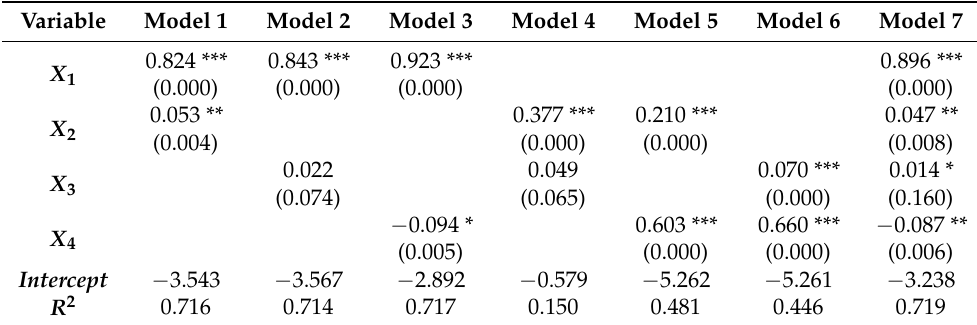
Table 5. QAP regression result of proximity